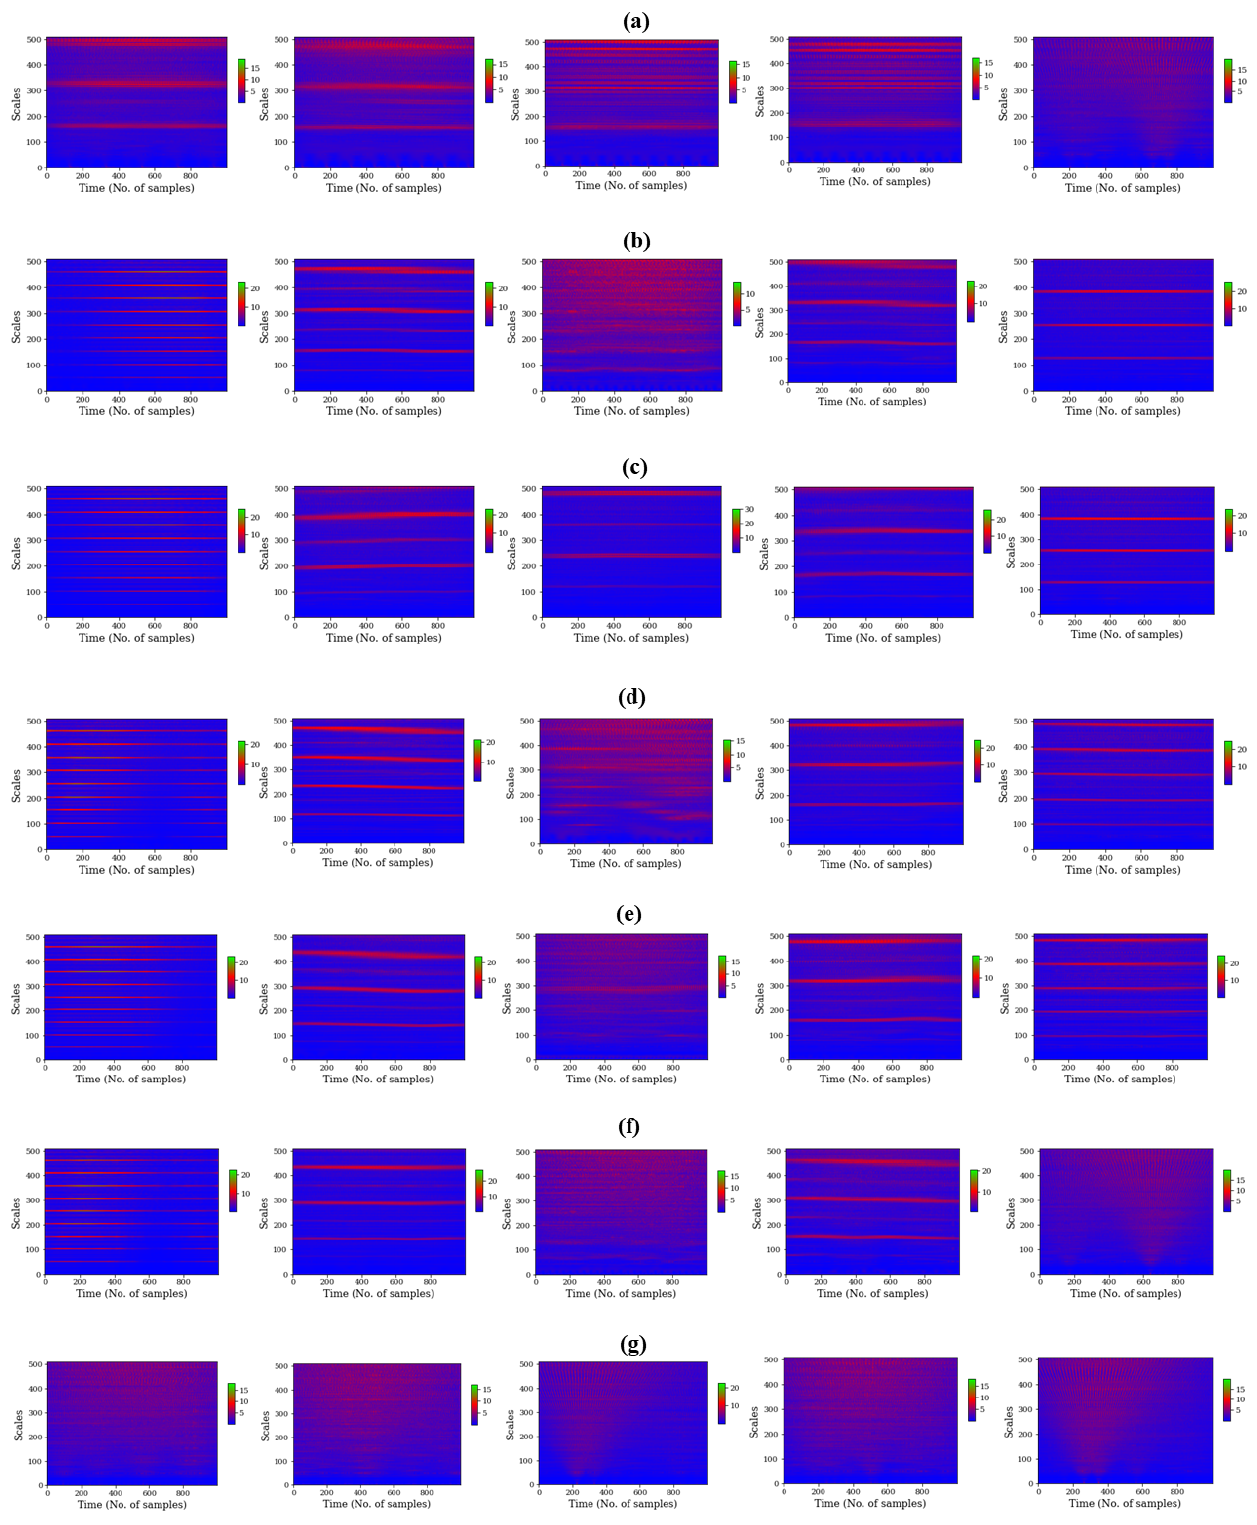
Figure 5. Wavelet spectra of the first-order differential of CR pressure signals for different emulsion compositions and increasing engine speeds (from left to right: 900, 1200, 1700, 1500, 2000 RPMs). ( a ) EM-0%, ( b ) EM-1.3%, ( c ) EM-1.5%, ( d ) EM-2.0%, ( e ) EM-5.0%, ( f ) EM-10.0%, and ( g )